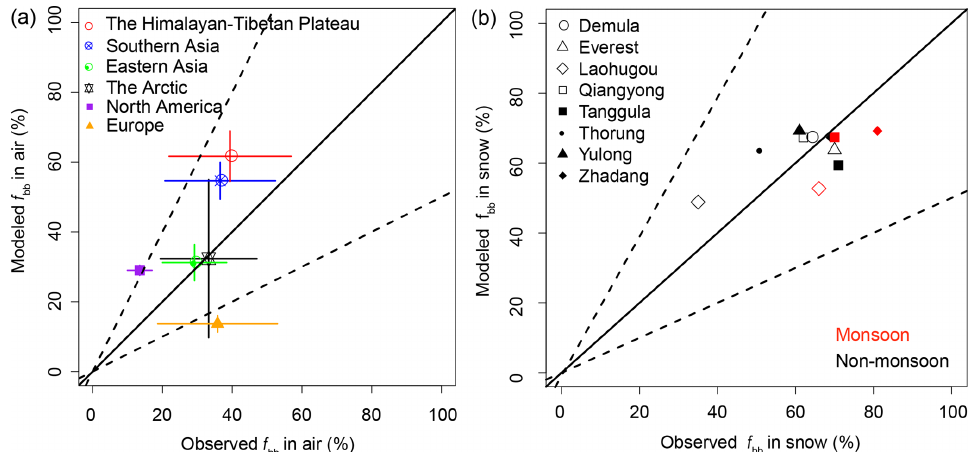
Figure 1. Observed and GEOS-Chem-simulated fraction of biomass burning ( f bb ; %) of (a) BC in the atmosphere in the Arctic, southern Asia, North America, Europe, eastern Asia and the Himalayan–Tibetan Plateau (the regions are symbol and color coded; see data in Table S2) and (b) BC in snow during monsoon (red) and non-monsoon (black) seasons over the Himalayan–Tibetan Plateau. Also shown in panel (a) are the standard deviations of observed and model simulated f bb in each region, reflecting the temporal and spatial variations of f bb in the region (horizontal and vertical lines). Observations of f bb in the atmosphere in panel (a) are from carbon isotope analysis as listed in Table S1. Observations of f bb in BC in snow in panel (b) are from Li et al. (2016). Solid lines in panels (a) and (b) are 1:1 ratio lines, and dashed lines are 1:2 (or 2:1) ratio